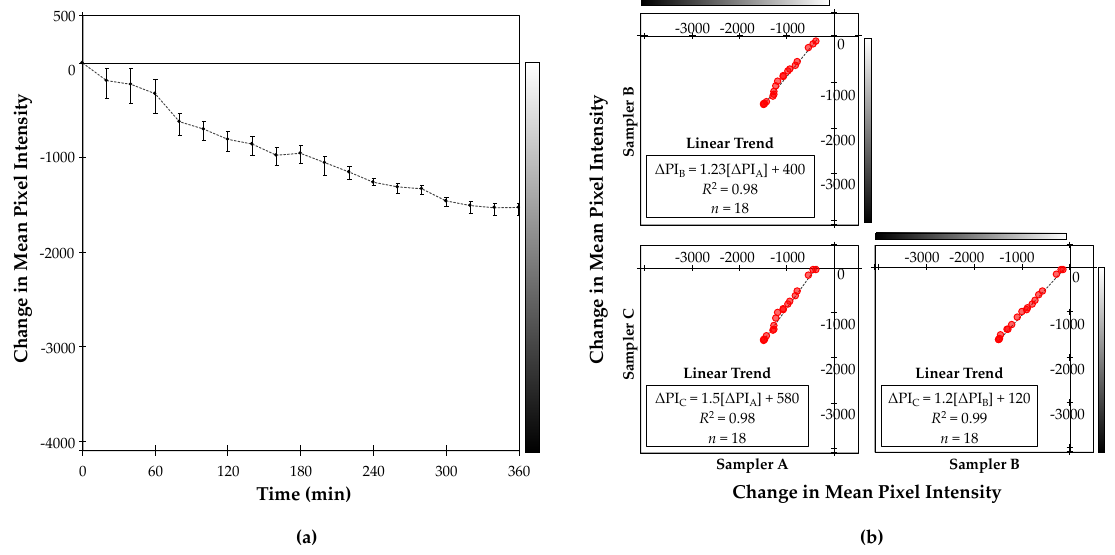
Figure 2. Change in reflectance of three samplers with exposure to kerosene smoke in a laboratory chamber. Change in reflectance (measured by change in mean pixel intensity ( ∆ PI; unitless) and illustrated by grayscale) ranges from 0 (indicating no change in grayscale) to − 4095 (indicating a change in from perfect white to perfect black). ( a ) Average change in reflectance of samplers versus time in kerosene smoke exposure chamber. Points indicate the mean and error bars indicate the range of change in reflectance for the three samplers placed together in the exposure chamber. ( b ) Scatterplot matrix of change in reflectance of three samplers (Samplers A, B, and C) placed together in the exposure